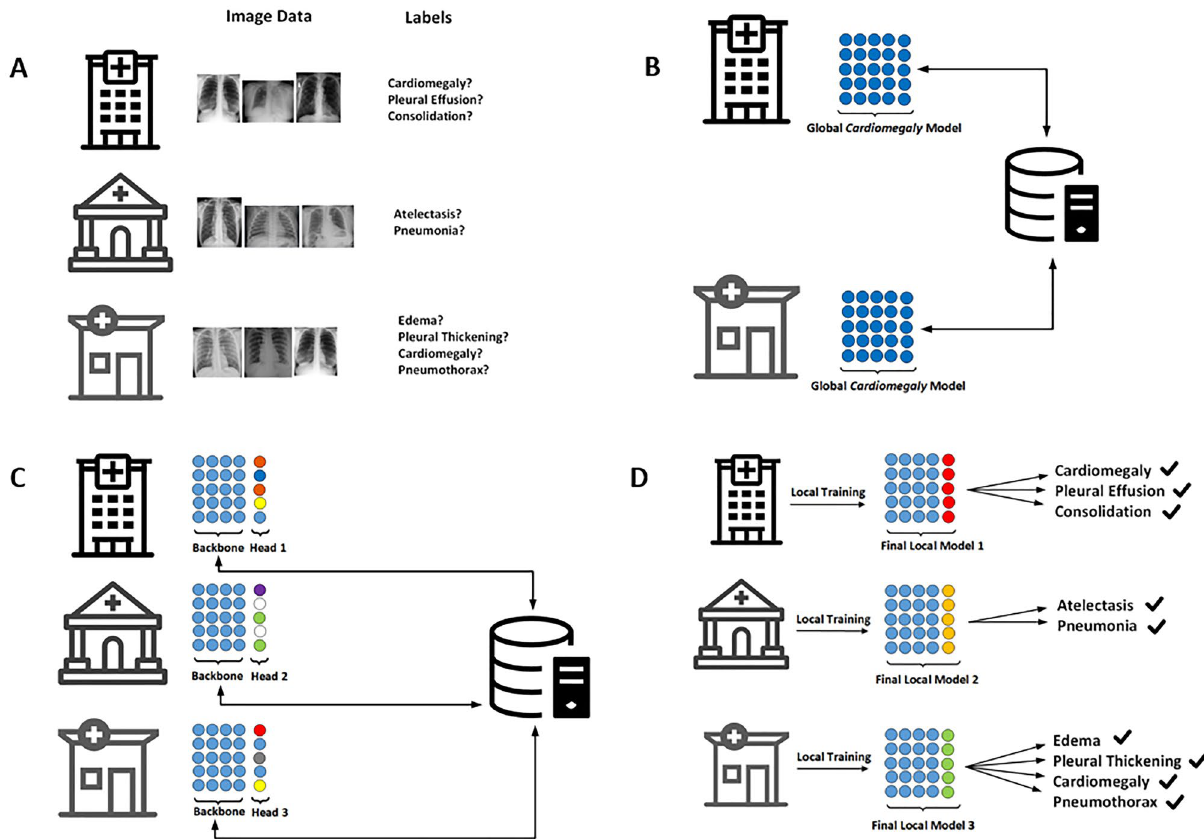
Figure 1. Overview of the flexible federated learning (FFL) process. ( A ) Three separate data centers intend to train AI models for the prediction of different diseases. ( B ) Conventional federated learning: only center 1 and center 3 who have overlapping objectives can collaborate on training a neural network for the detection of cardiomegaly only. ( C ) FFL: all centers collaborate to train a common backbone network and individual classification heads using all their data. ( D ) For classification, each center employs the common backbone and the local classification